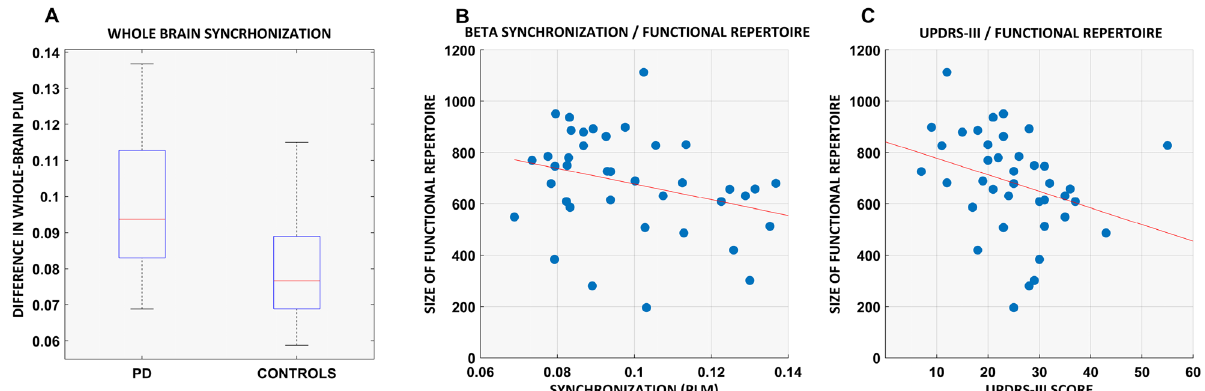
Figure 3. Relationship between flexibility of brain dynamics, clinical disability and global synchronization. ( A ) Individual whole-brain average PLM in PD and controls ( B ) Correlation between global synchronization, estimated using the phase linearity measurement (PLM) in the beta band (13–30 Hz), and the size of the functional repertoire. ( C ) Correlation between motor impairment, estimated using the Unified Parkinson disease rating scale—III, and the size of the functional